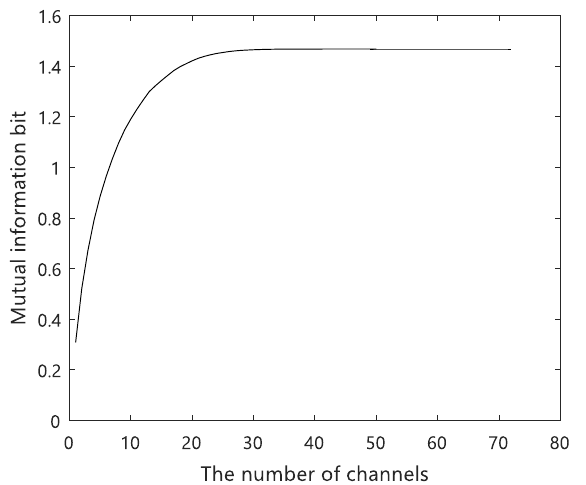
Figure 5. Ascending cumulative graph of mutual information of channels. The information corre- sponding to 81% of the entire observation range is included in the first 10